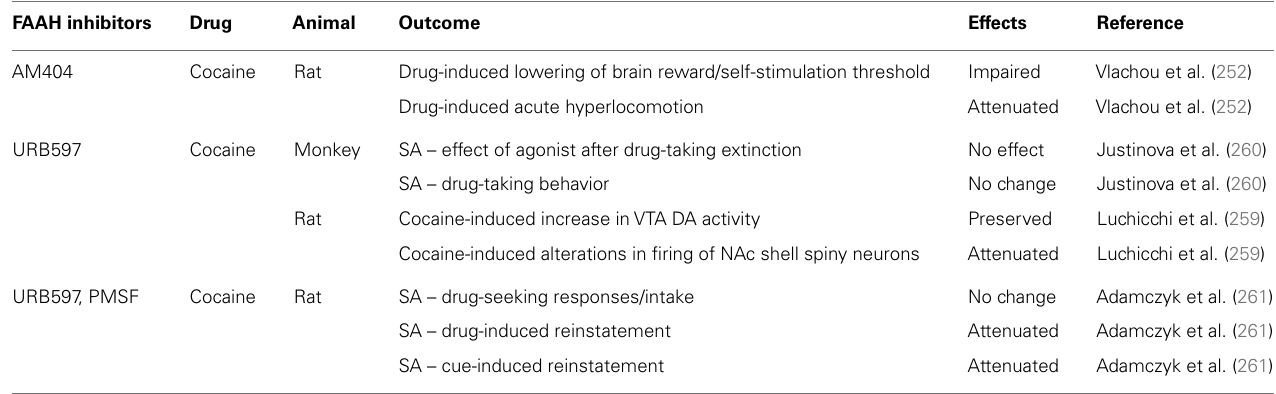
Table 2 | Pharmacological inhibition of FAAH inhibition and properties of